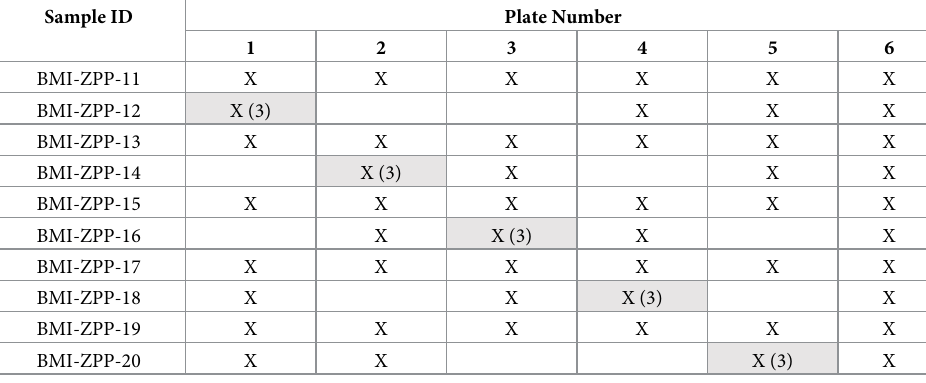
Table 3. Plate layout used at Laboratory E.